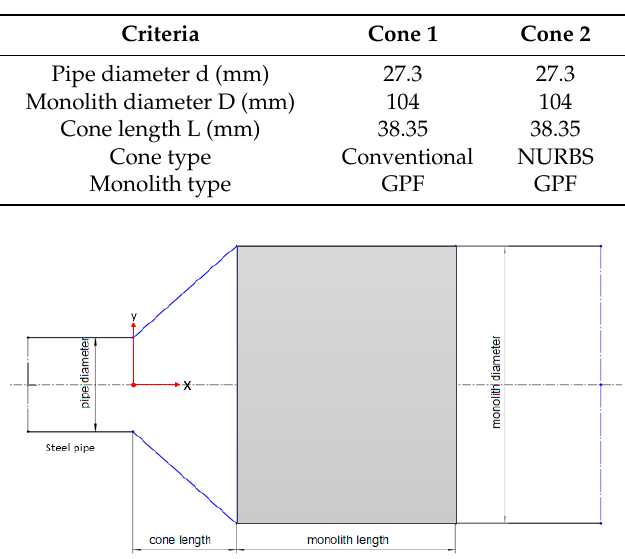
Figure 2 . Schematic of the gasoline particulate filter (GPF).